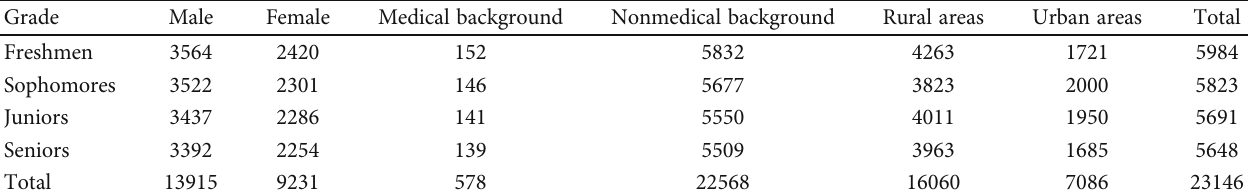
Table 1: Sampling distribution of undergraduate students from the university in